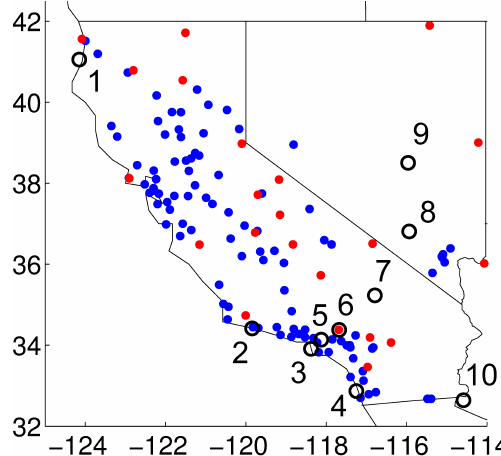
Fig. 1. Map of ground stations used for evaluation in the study. AQS, IMPROVE and AERONET site locations are shown in blue dots, red dots and black rings, respectively. Numbers correspond to AERONET sites: (1) Trinidad Head, (2) UCSB, (3) El Se- gundo, (4) La Jolla, (5) Caltech, (6) Table Mountain, (7) Goldstone, (8) Frenchman Flat, (9) Railroad Valley, and (10)